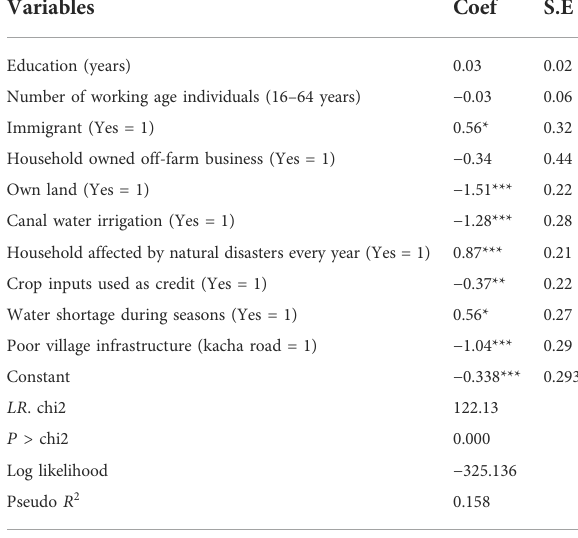
TABLE6Logitregressionresults(dependentvariablesarewhetherthe farm exit farm).